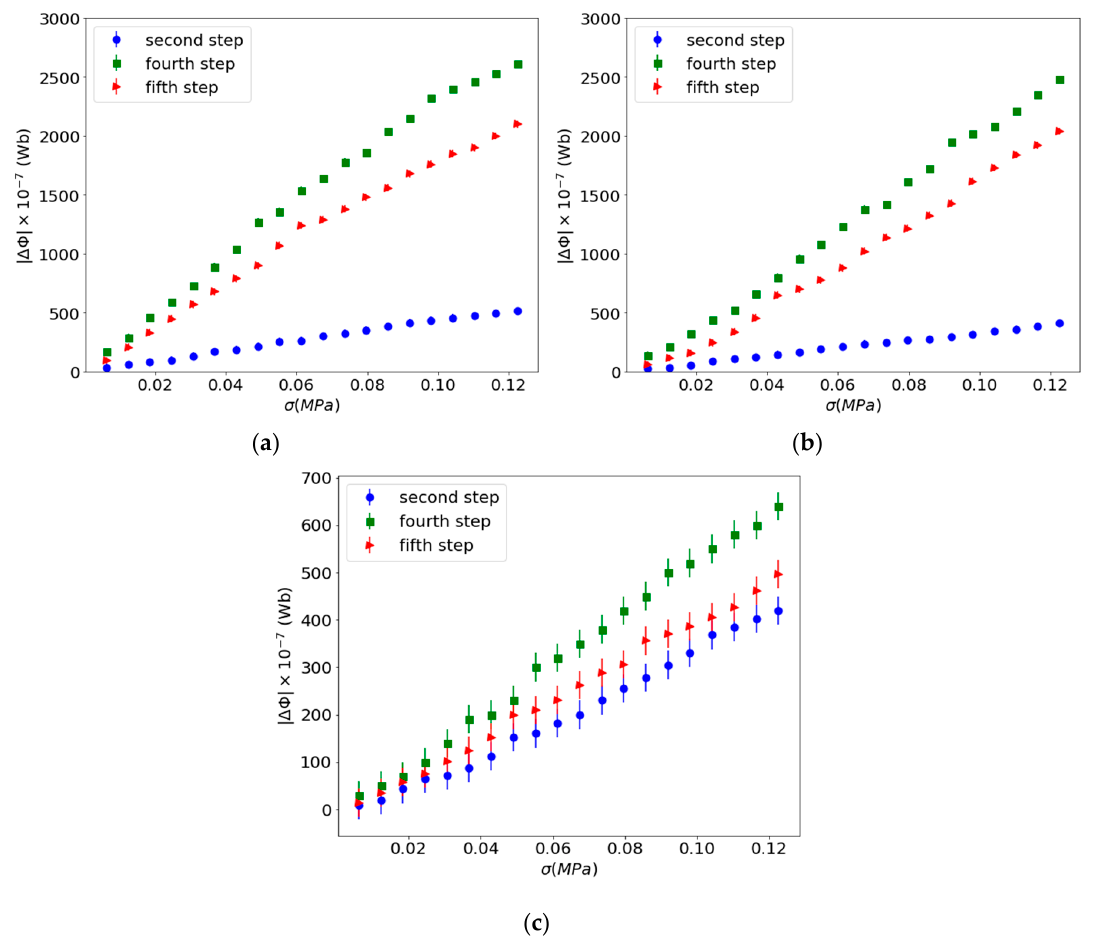
Figure 7. Results of the Villari effect in the different steps of the experiment: ( a ) Composites with 45 wt.%; ( b ) composites with 65 wt.%; ( c ) composites with 75 wt.%.